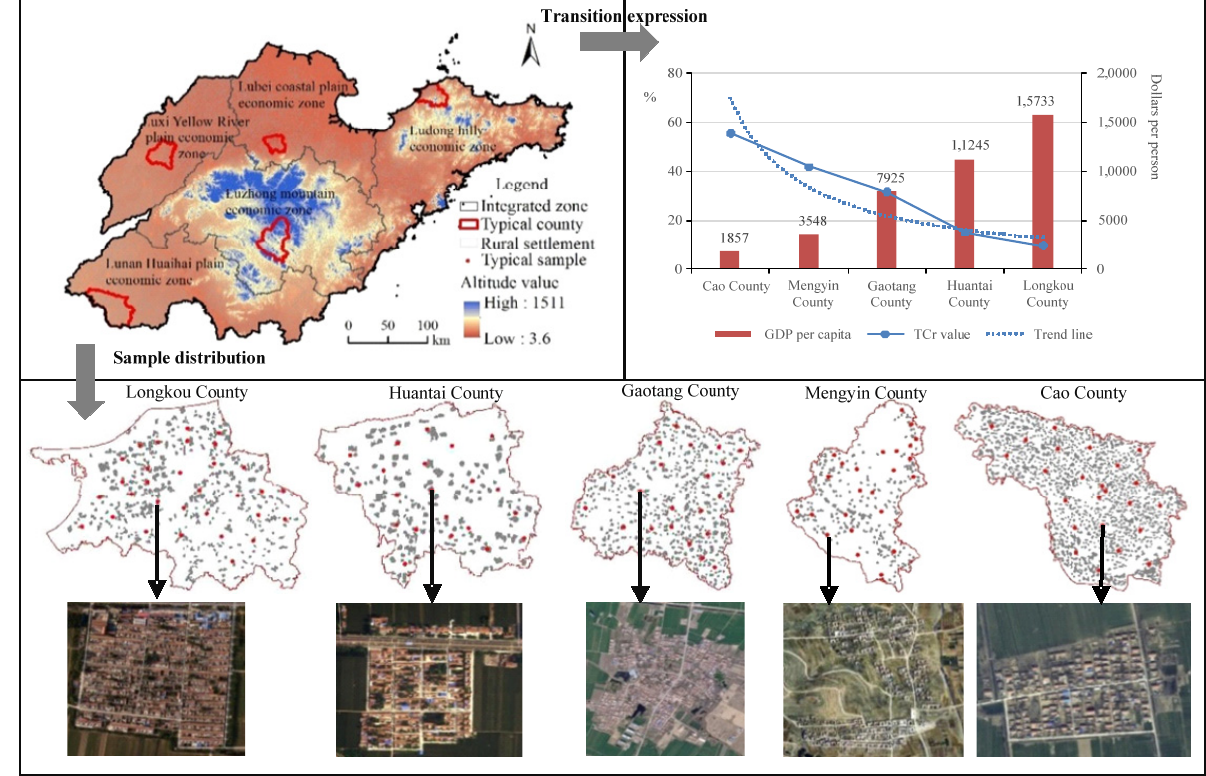
Figure 5. Distribution of typical sample areas and points in different transition stages.